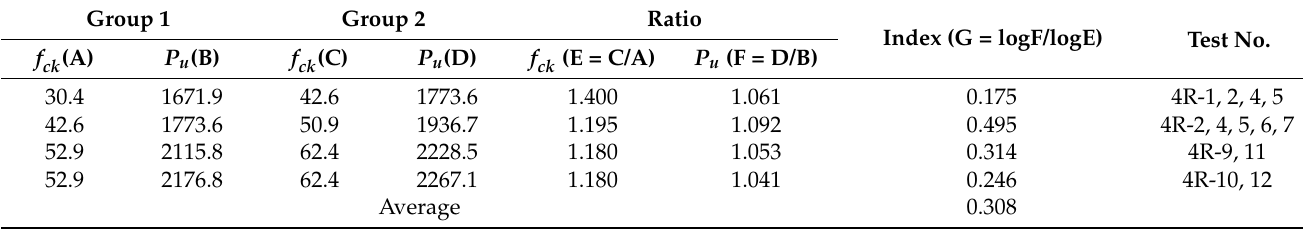
Table 8. Index values for the variable of f ck